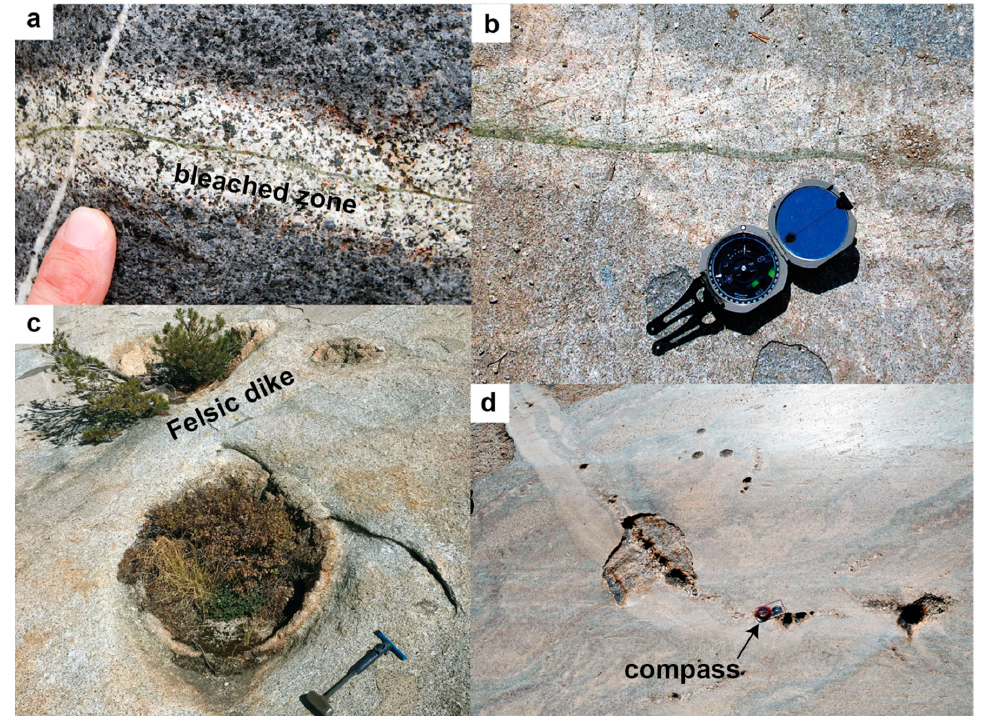
Figure 4. Field evidence of focused fluid transport in granitic plutons. ( a ) Fracture filled with hydrothermal epidote; diorite near Mack Lake, Sierra Nevada, California, USA. Note bleached zone around the vein. ( b ) Epidote-filled fracture network and surrounding bleached zone, Piute Creek, Sierra Nevada, California. ( c ) Pits weathered into large hydrothermal pipes, in and adjacent to felsic dike, Yosemite National Park, USA. ( d ) Line of pits weathered into hydrothermal pipes along contact of felsic dike, Yosemite National Park, USA (compass with 5 cm ring indicates scale).